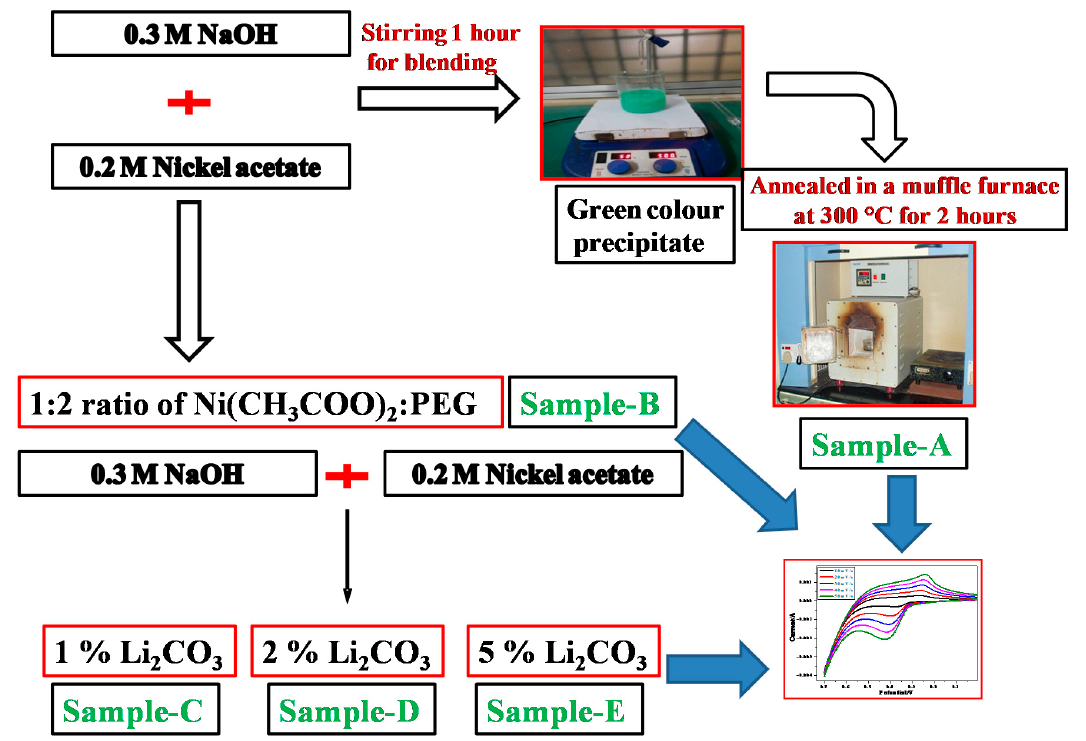
Figure 2. Flow chart for the synthesis of different NiO nanoparticles.